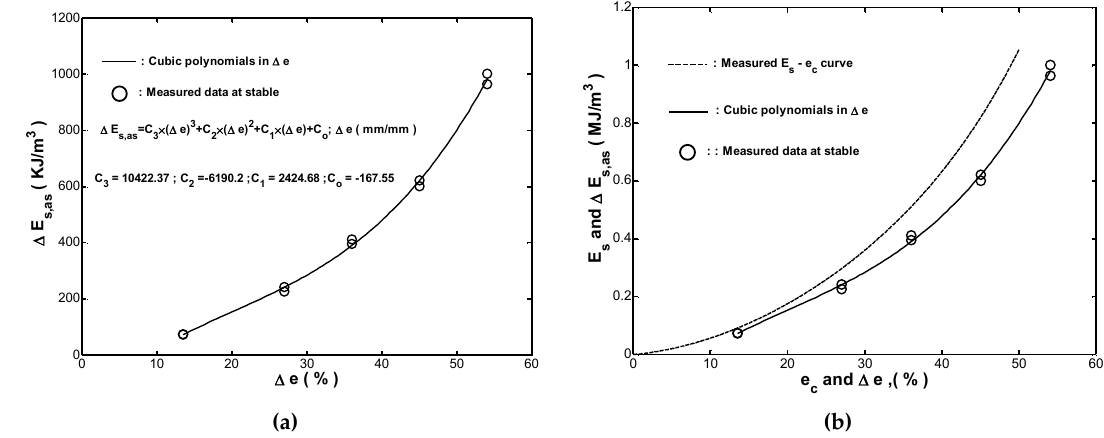
Figure 11. ( a ) Comparison of fitted 𝐸 (cid:3046),(cid:3028)(cid:3046) − ∆𝑒 curve and ( ∆𝑒, 𝐸 (cid:3046),(cid:3046) ) data at stable for cyclic straining test performed with 𝐴 (cid:3032) = −1 , and ( b ) comparison of measured 𝐸 (cid:3046) − 𝑒 (cid:3030) curve and fitted 𝐸 (cid:3046),(cid:3028)(cid:3046) − ∆𝑒 curve.